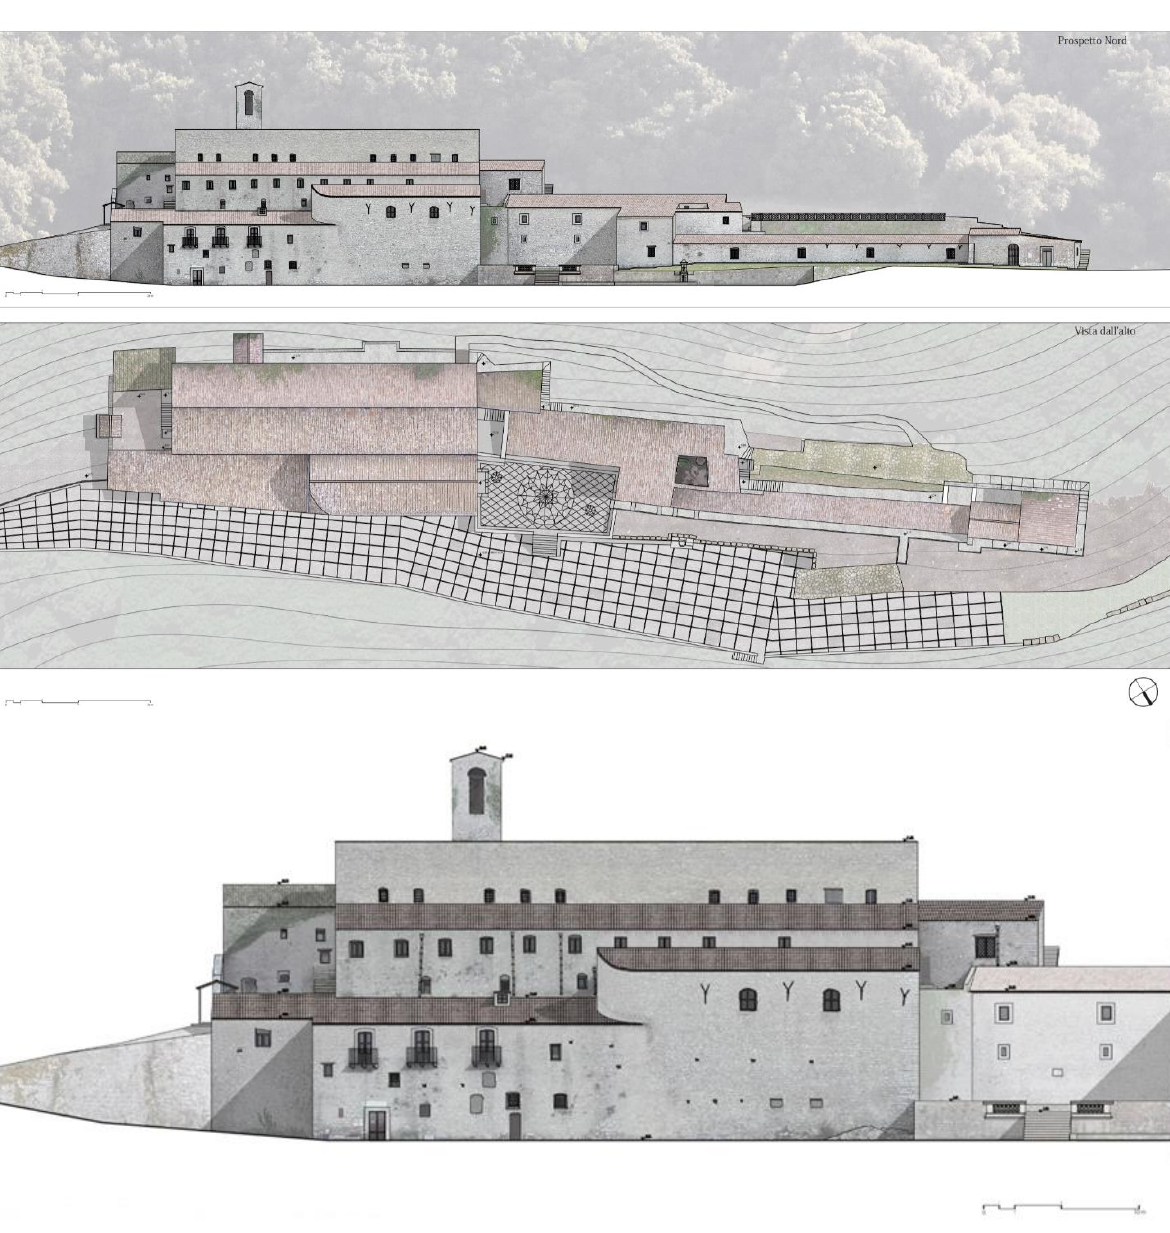
Figure 9. Ortoprojections of the façade and of the above view of the